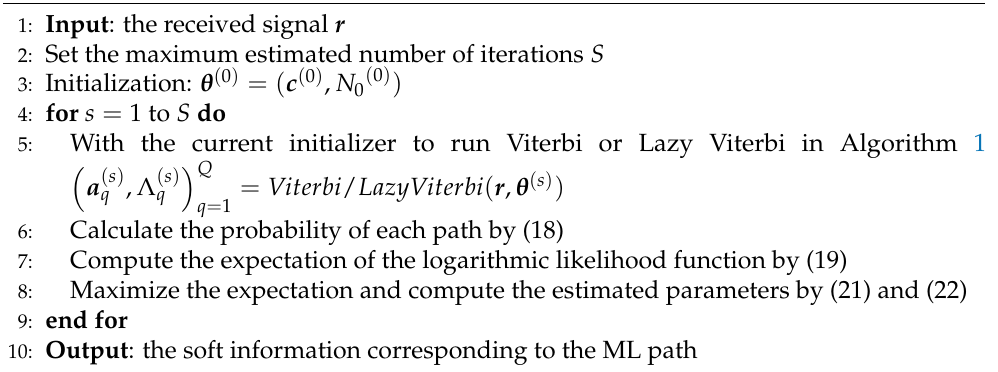
Algorithm 2 The EMVA/EMLVA blind